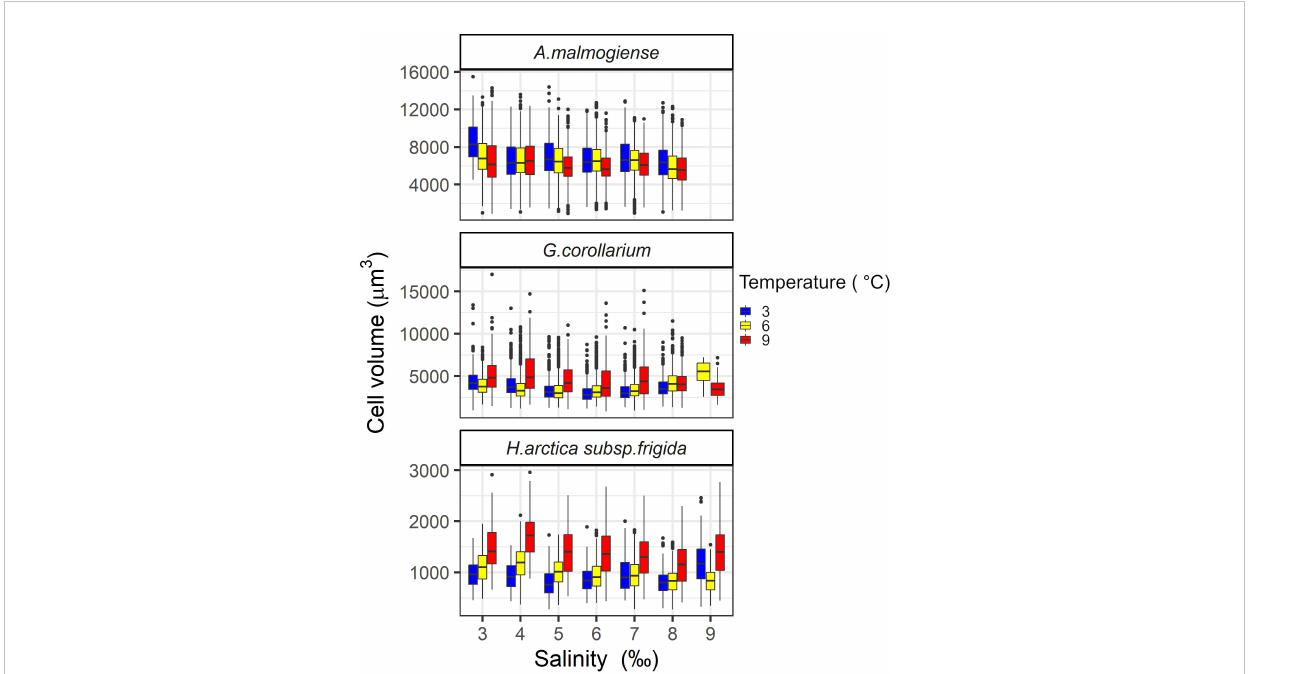
FIGURE 2 Variations in cell volumes of Apocalathium malmogiense , Gymnodinium corollarium , and Heterocapsa arctica subsp. frigida after the pre- acclimation to the salinities and temperatures used in the